Question: What does this figure show? Answer in one sentence.
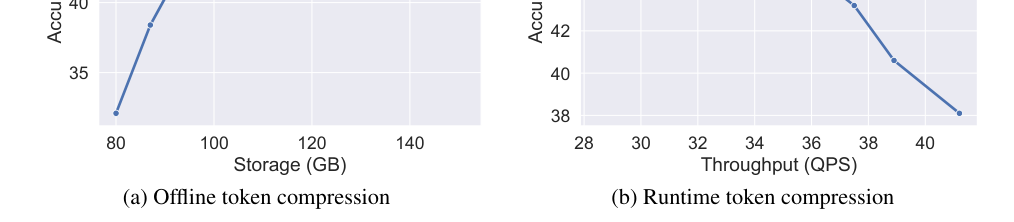
Answer: Accuracy, storage, and throughput comparisons for different two-stage token compression ratios on the NaturalQuestions dataset. To achieve a good balance between accuracy, storage, and throughput in BTR, we choose a compression ratio of 0.2 for both online and offline token compression. Detailed numbers are in Table 9 in Appendix A.6.